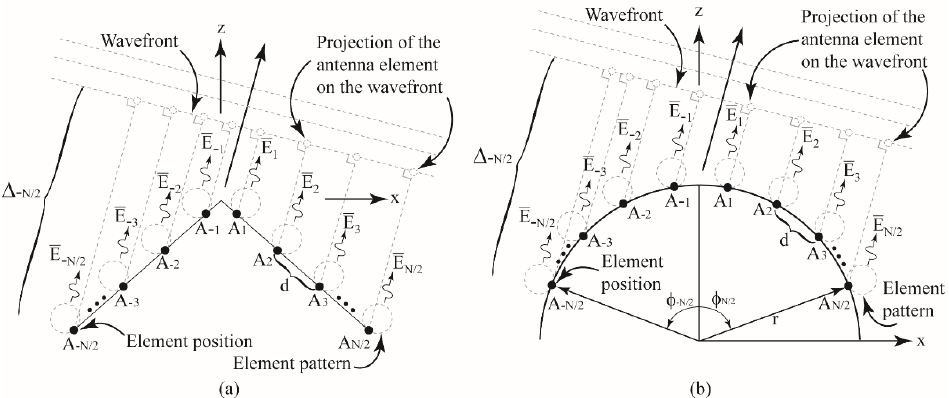
Figure 1. ( a ) Illustration of the antenna elements on a singly curved (wedge) surface and ( b ) illustration of the antenna elements on a cylindrical-shaped surface.